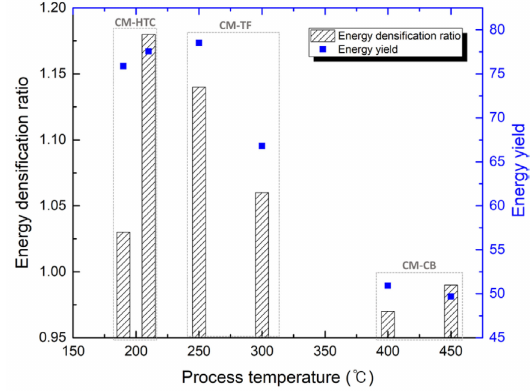
Figure 4. Energy densification ratio and energy yield of the hydrochar, torrefied char, and biochar derived from cattle manure.